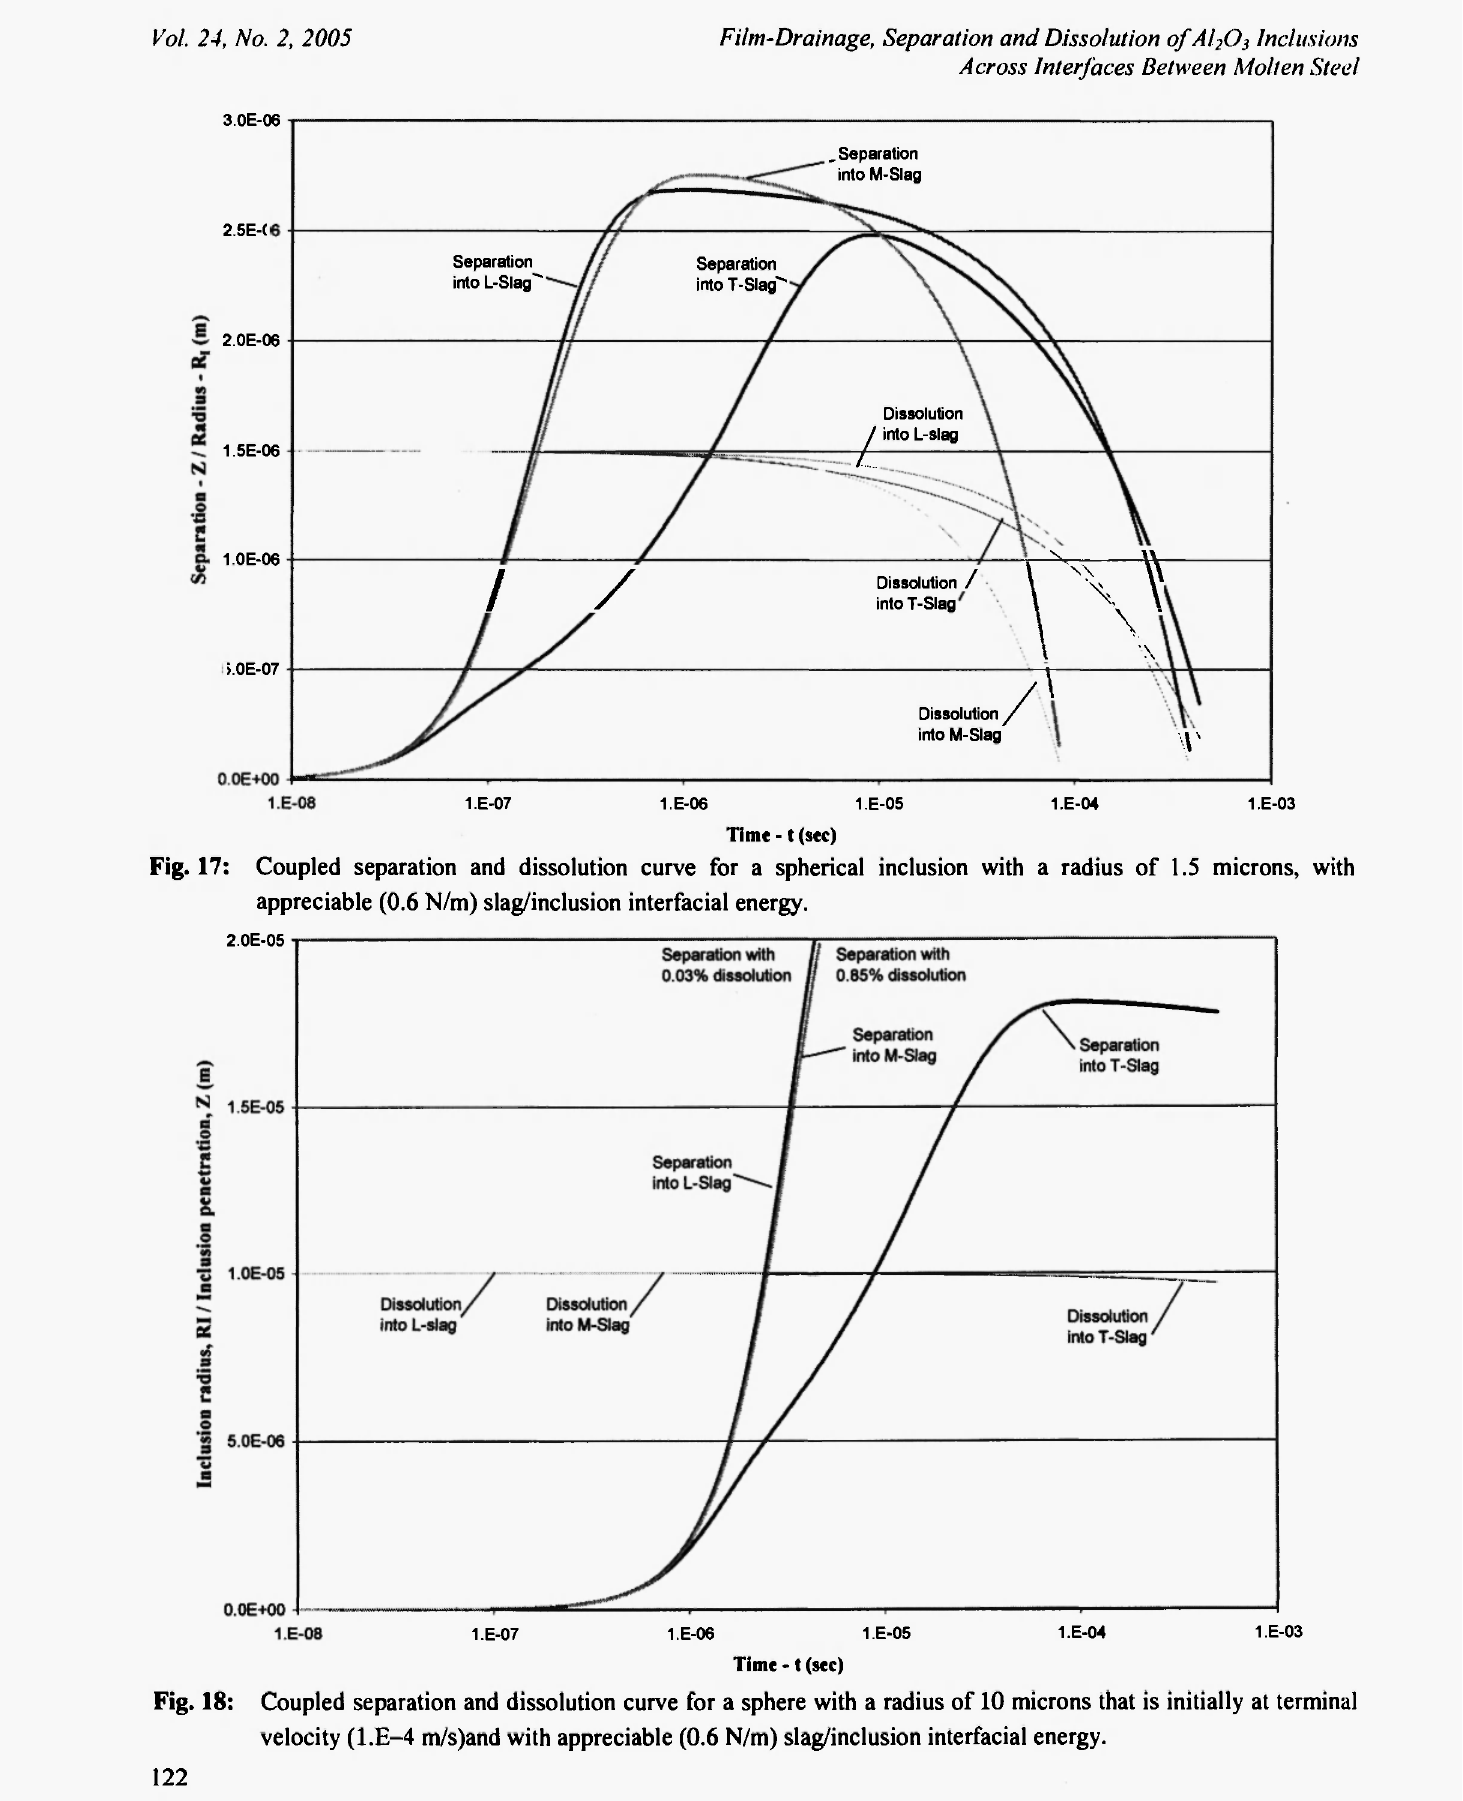
Fig. 18: Coupled separation and dissolution curve for a sphere with a radius of 10 microns that is initially at terminal velocity (l.E-4 m/s)and with appreciable (0.6 N/m) slag/inclusion interfacial